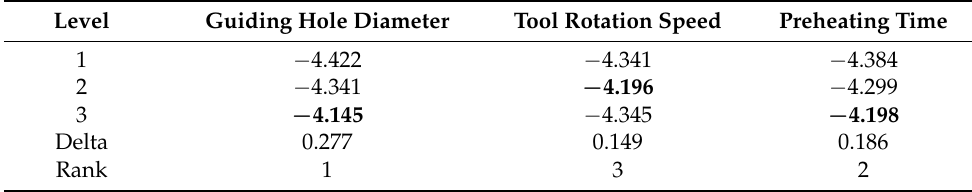
Table 7. Response table of S/N ratios (the larger the better).